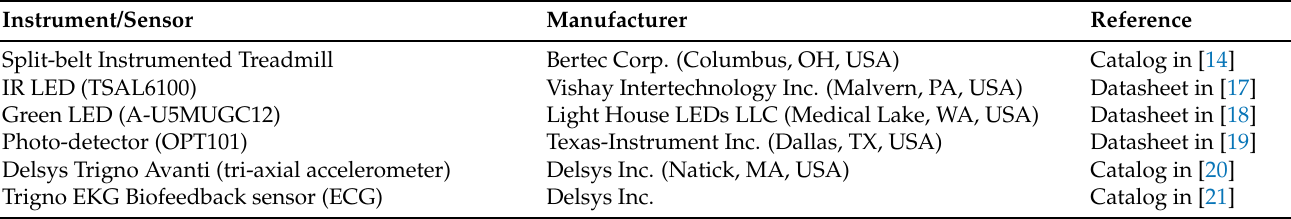
Table 1. Instruments used for data collection in the exercise